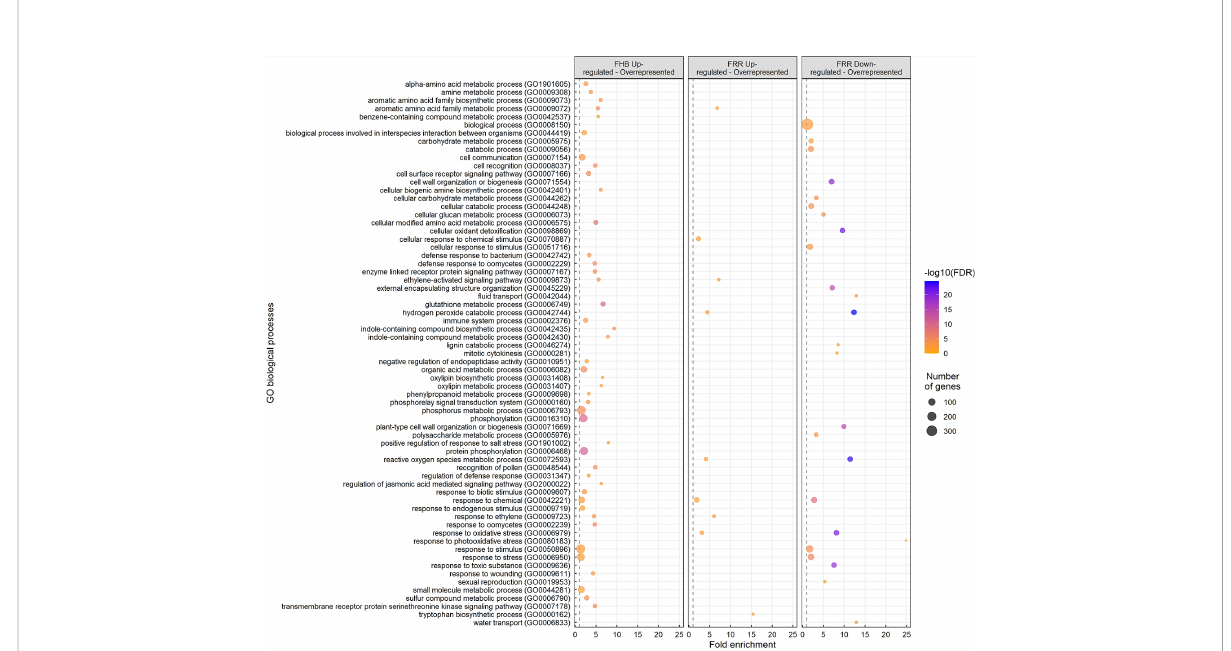
FIGURE 2 Overrepresented biological processes from signi fi cantly upregulated and downregulated genes in FHB and FRR. The dot size represents the number of genes within the process and the dot colour represents the enrichment signi fi cance (-log10 (False Discovery Rate (FDR) - corrected p-value)). The vertical dotted lines denote a fold enrichment threshold of 1 signifying that the biological processes are overrepresented. Data in Supplementary Table